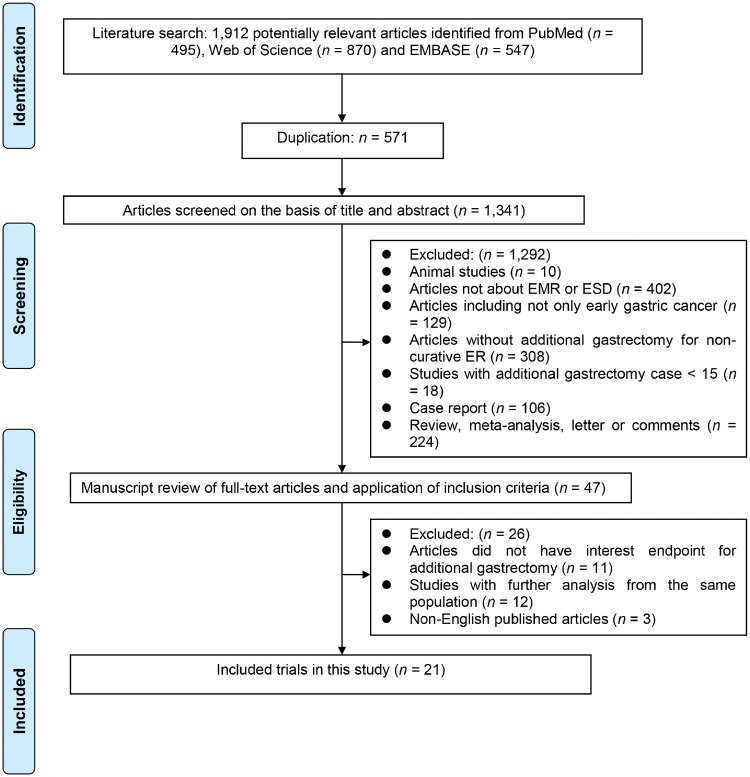
Study flow diagram of the included studies. EMR, endoscopic mucosal resection; ESD, endoscopic submucosal dissection; ER, endoscopic resection.